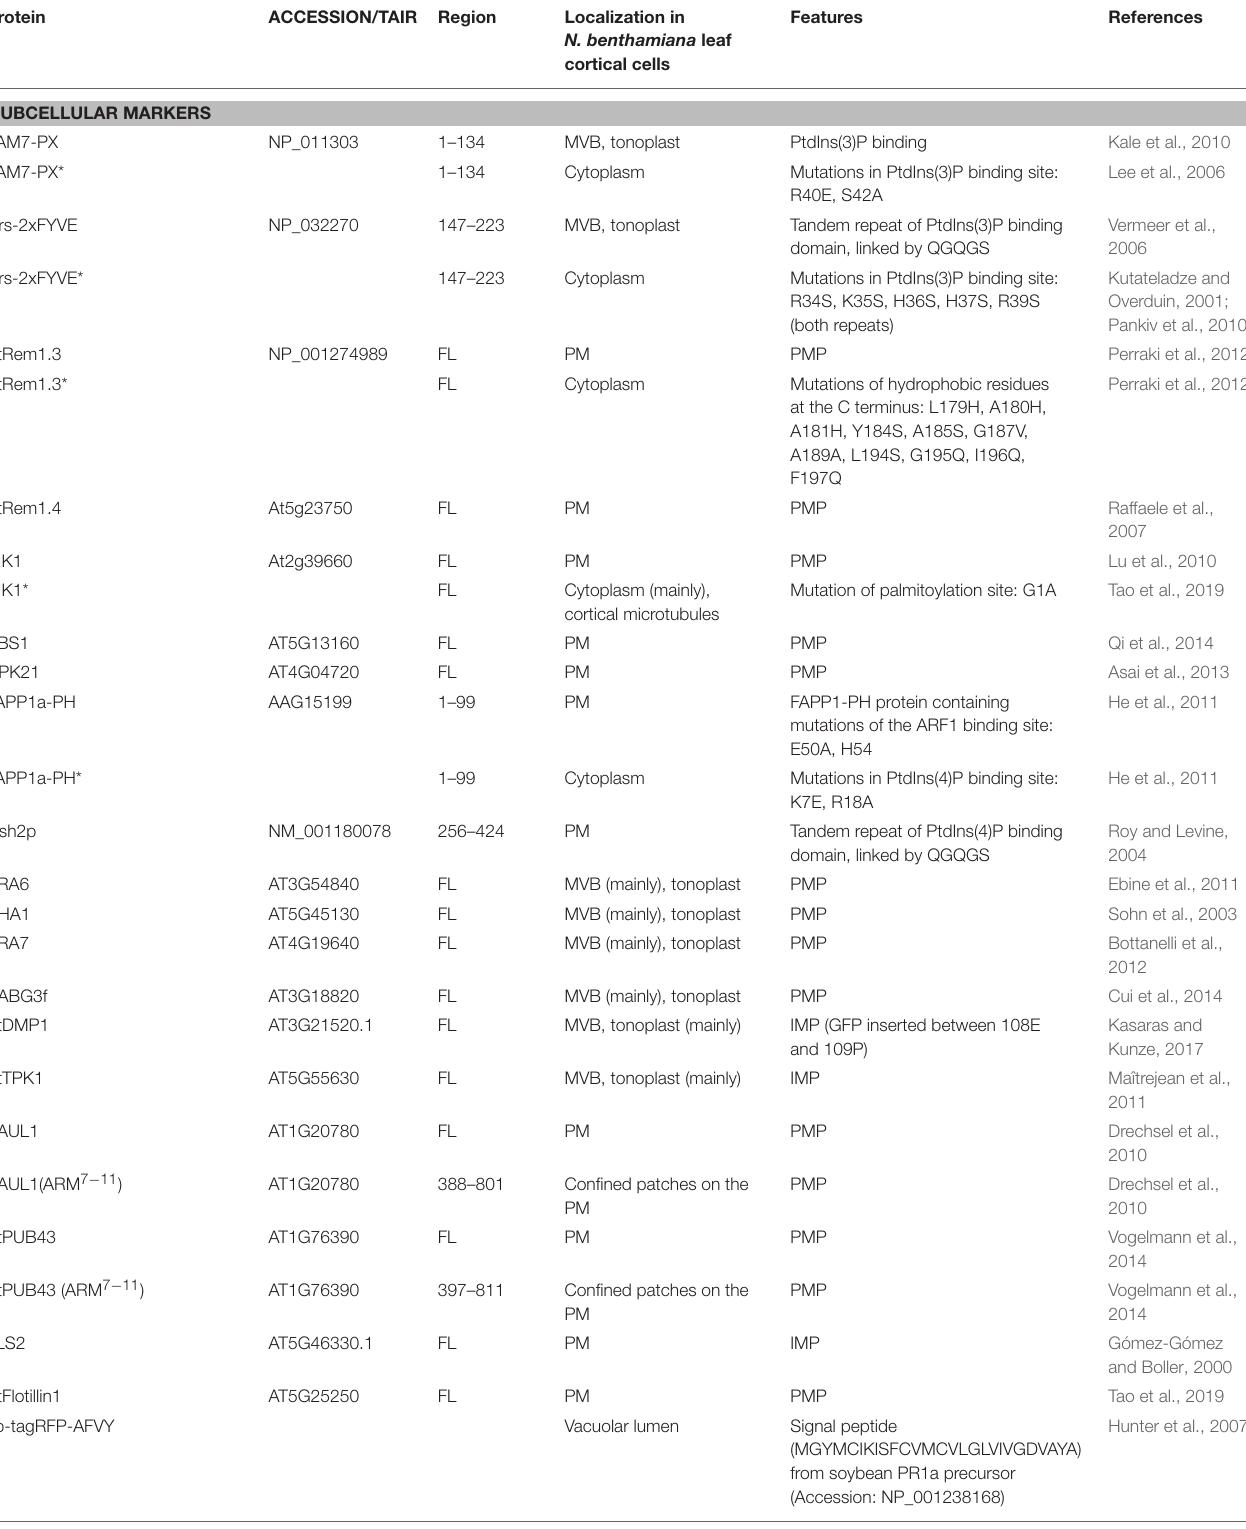
TABLE 1 | Fluorescent marker proteins and mutants used in this study.